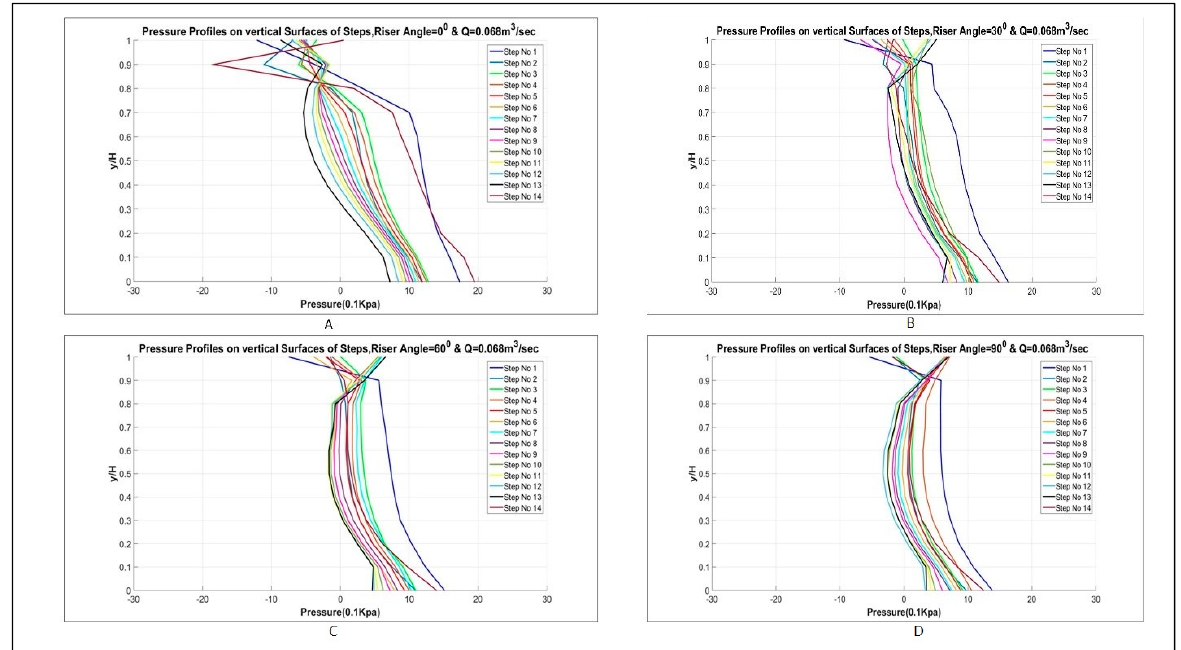
Figure 13. Pressure profiles for ( A ) simple stepped, ( B ) 30 ◦ , ( C ) 60 ◦ , and ( D ) 90 ◦ curved risers spillway for the head of 220